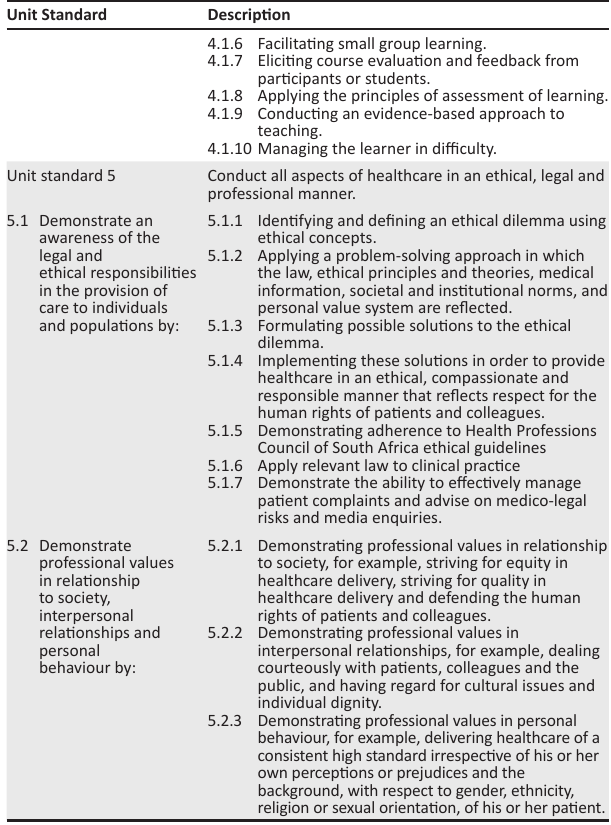
TABLE 2 (Continues...): Programmatic learning outcomes. Unit Standard Description